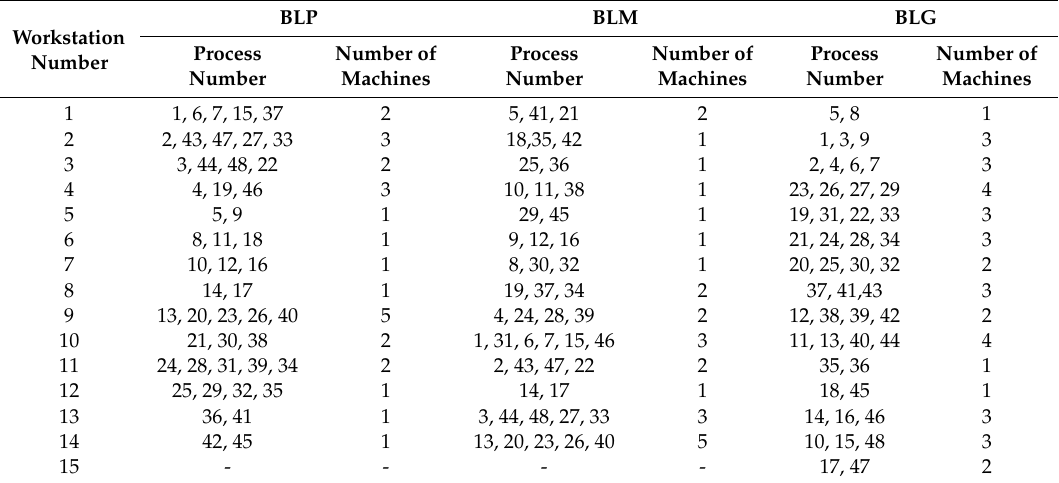
Table 2. Balancing schemes of assembly lines with di ff erent workstation layouts. BLP: the order